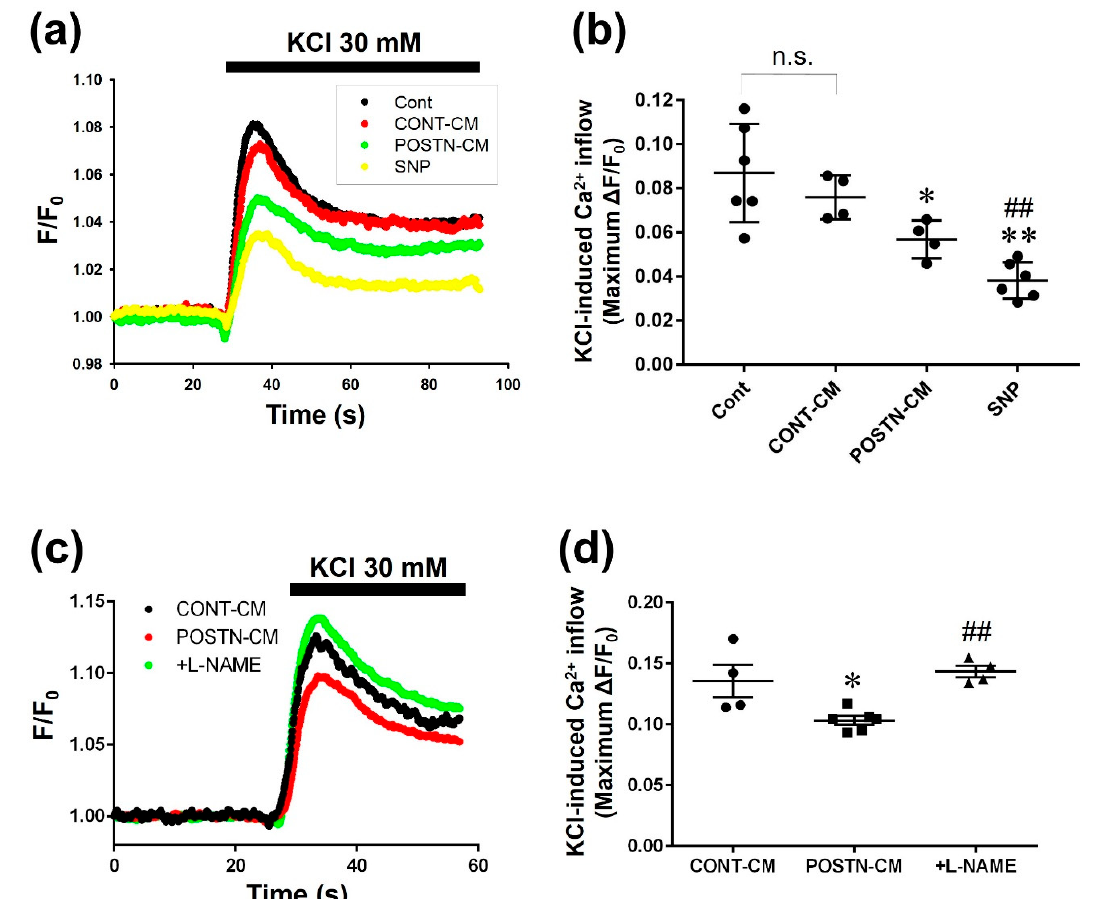
Figure 6. Culture media (CM) derived from POSTN-stimulated RVFbs inhibited Ca 2+ inflow through L-type Ca 2+ channel (LTCC) in H9c2 cardiomyoblasts. RVFbs were stimulated for 24 h with recombinant rat POSTN (1000 ng/mL) or solvent (CONT). Then, the RVFbs were incubated in new serum-free Dulbecco Modified Eagle's Medium containing L -arginine (1 mM) for 24 h in the presence or absence of pretreatment with L-NAME (600 μ M, 10 min). CM derived from solvent-stimulated RVFbs (CONT-CM) and from POSTN-stimulated RVFbs in the presence (+ L -NAME) or absence (POSTN-CM) of L -NAME were collected. H9c2 cardiomyoblasts grown to confluent on a coverslip were treated with the CM. Ca 2+ inflow through LTCC was measured by a fluorescent calcium measuring system using Fura-2 AM, a fluorescent calcium indicator. F340/F380 ratio (F), was calculated and normalized by the basal fluorescence (F 0 ) at 30 seconds before KCl (30 mM)- stimulation (F/F 0 ). ( a ) Average time course of F/F 0 in H9c2 cardiomyoblasts treated for 1 h with milliQ (Cont), CONT-CM, POSTN-CM or sodium nitroprusside (SNP, 100 μ M). The fluorescence